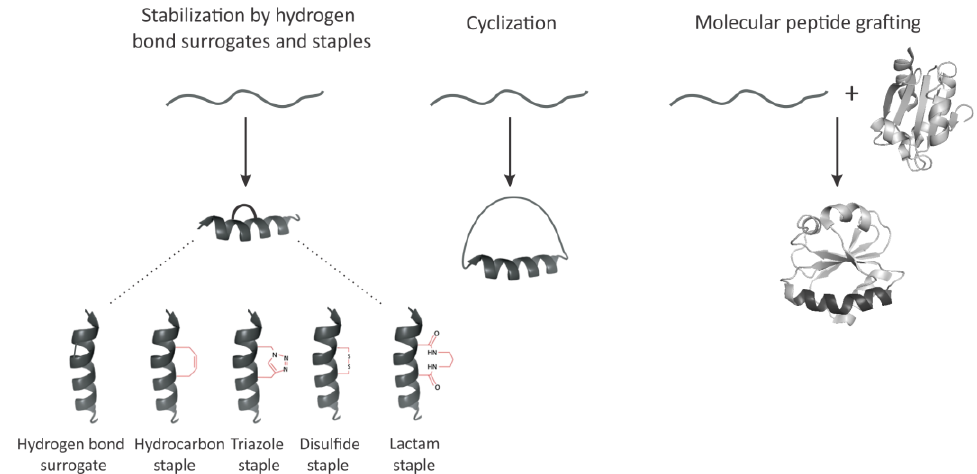
Figure 3. Representative stabilization methods for short peptides. Peptide backbone stabilization can be achieved via a hydrogen bond surrogate strategy and/or introduction of staples ( left ), peptide cyclization ( middle ) and/or grafting onto a desired scaffold ( right ).